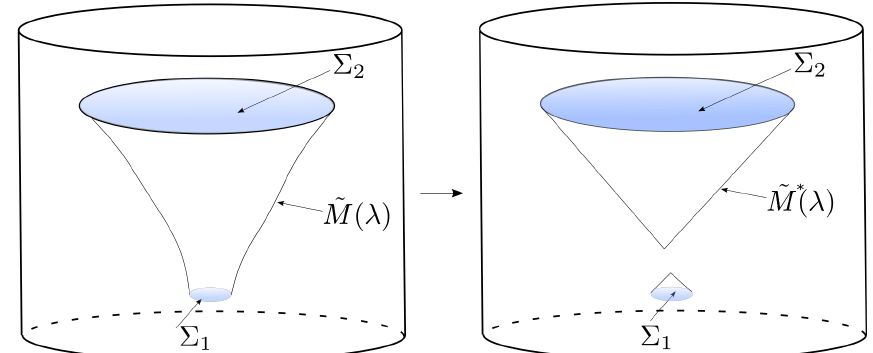
Figure 7: Optimisation of the Lorentzian cost functional given by a sum of bulk and boundary volume. The minimal cost is obtained as ˜ M approaches an almost null surface. As Σ is shrunk to a point, one obtains the past half of the WDW patch 1 anchored to Σ 2